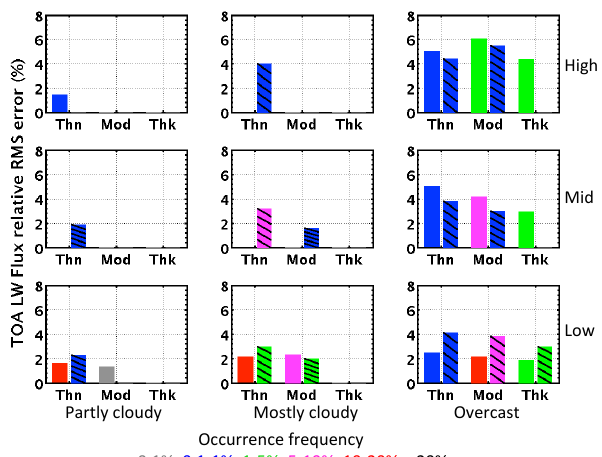
Figure 9. TOA daytime LW flux consistency (%) between nadir- and oblique-viewing angles for different cloud types over ocean. The left bars are for single-layer clouds, and the right bars (hatched) are for multiple-layer clouds. The color of the bar indicates the oc- currence frequency for each cloud type.